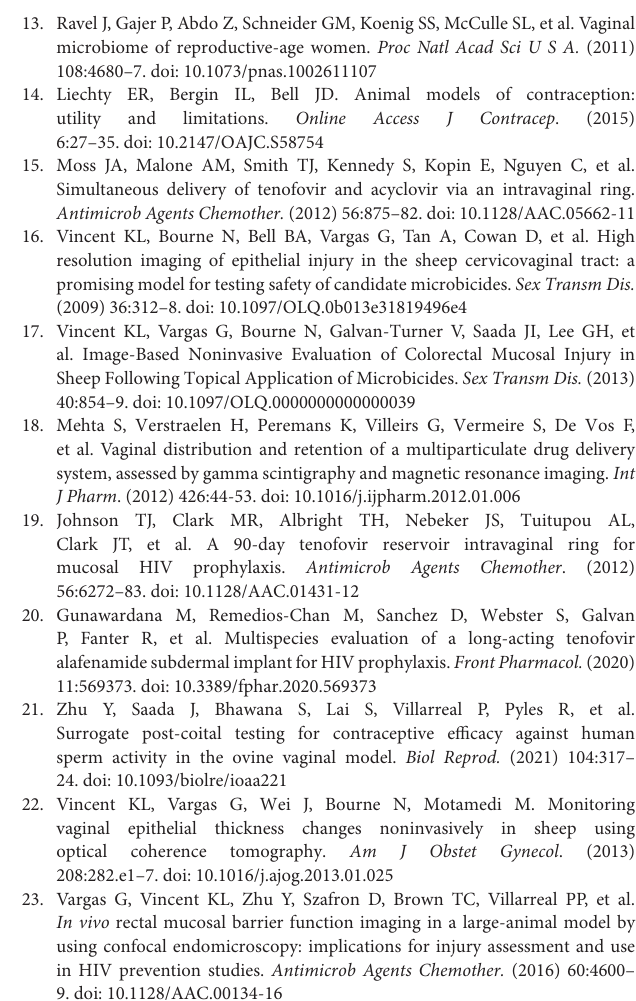
Supplemental Figure 1 | Average longitudinal shGAPDH and 16S copies detected by study day in each of the four groups of phase 3 animals. The average number of shGAPDH (left) or 16S bacterial rDNA (right) quantified by quantitative polymerase chain reaction (qPCR) are shown over time. SDs are plotted. Sham animals are shown in black, hydroxyethylcellulose (HEC)- treated in red, nonoxynol-9 (N9)-treated in green, and benzalkonium chloride (BZK)-treated shown in